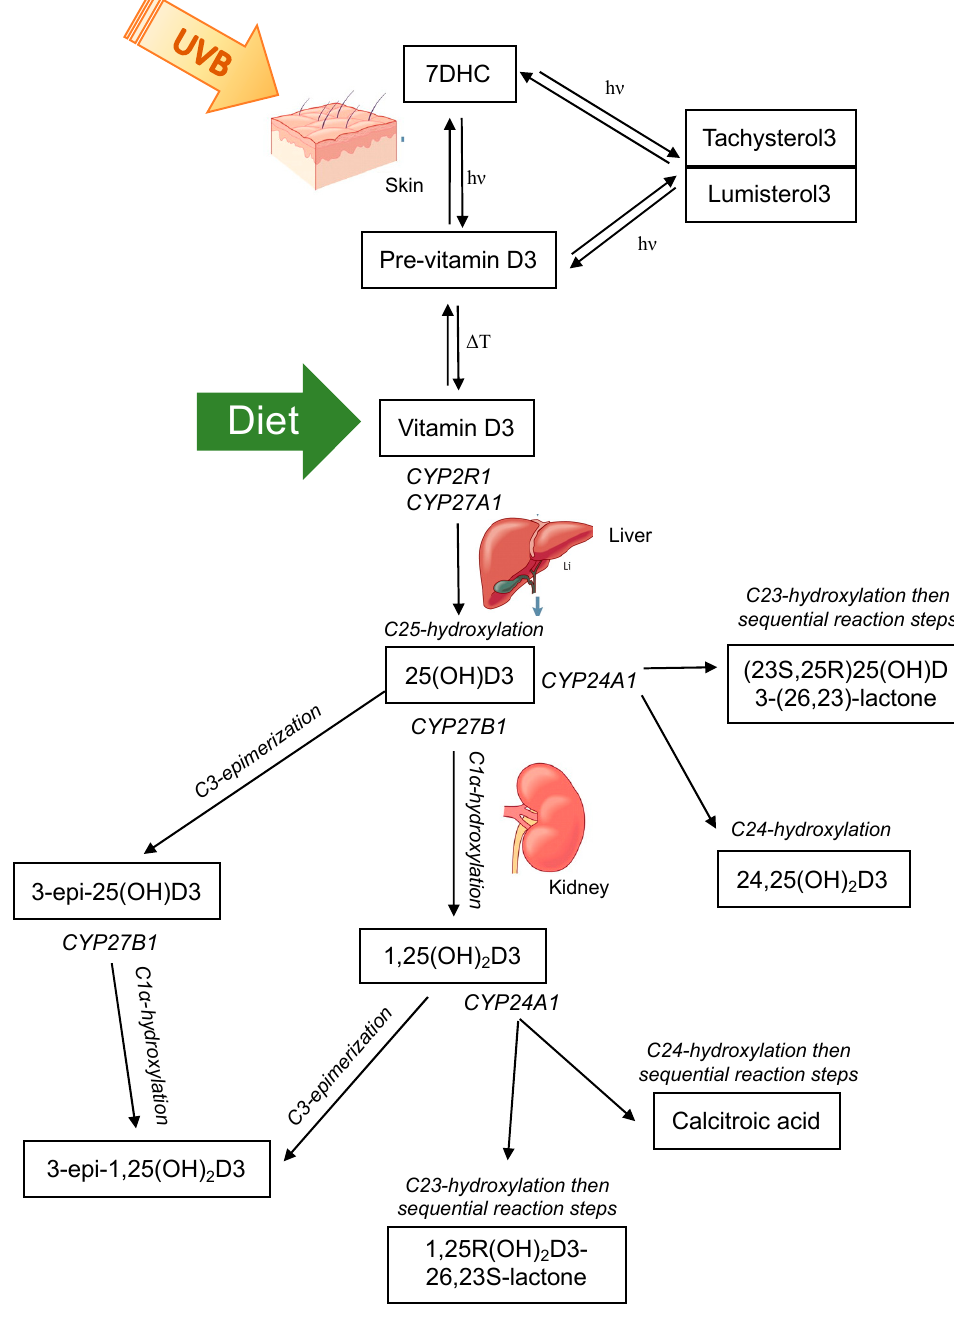
Figure 1. The major classical vitamin D pathway, whereby vitamin D3 is either produced in the skin via photochemical (h ν ) conversion of 7-dehydrocholesterol (7DHC) to pre-vitamin D3 and subsequent thermoisomerization ( ∆ T) to vitamin D3, or consumed in the diet. Vitamin D3 is hydroxylated at C25 in the liver by CYP enzymes and then subsequently subject to further hydroxylation or C3-epimerization in the kidney. Note that vitamin D2 is activated by CYP2R1 and CYP27B1 and can undergo C24 hydroxylation and C3-epimerization as shown for vitamin D3, but is only consumed through the diet and not endogenously produced.